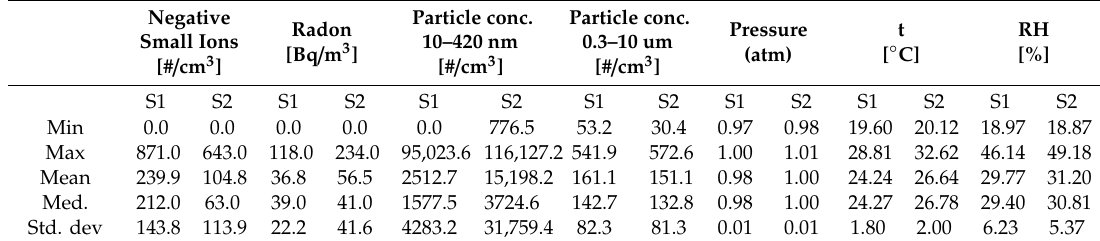
Table 1. Summary statistics (minimum, maximum, mean, median and standard deviation) of air quality variables for the campaign conducted in Schools 1 (S1) and 2